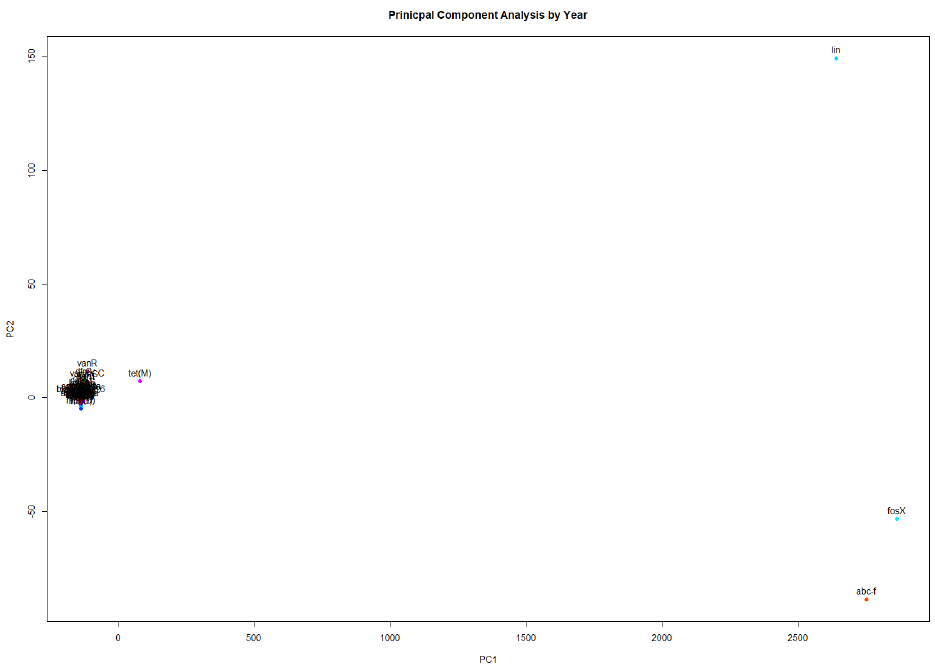
Figure 3. PCA to identify the most frequently occurring AMR genes in L. monocytogenes samples.